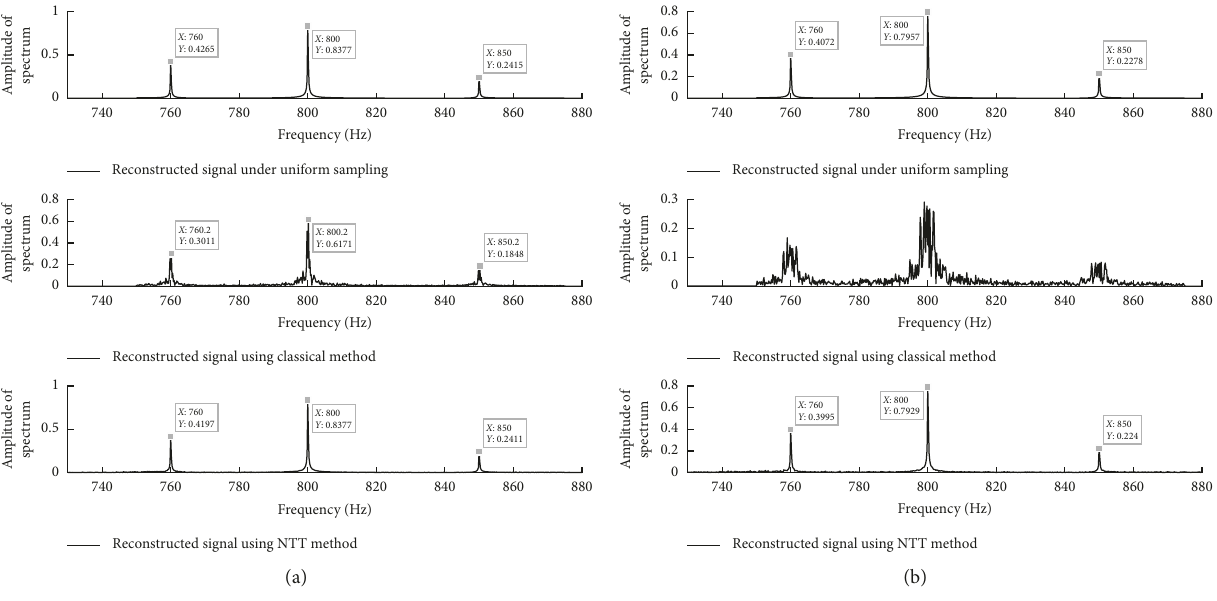
Figure 7: Comparisons of reconstructed vibration spectrums using different methods: (a) URS � 3.16%; (b) URS �